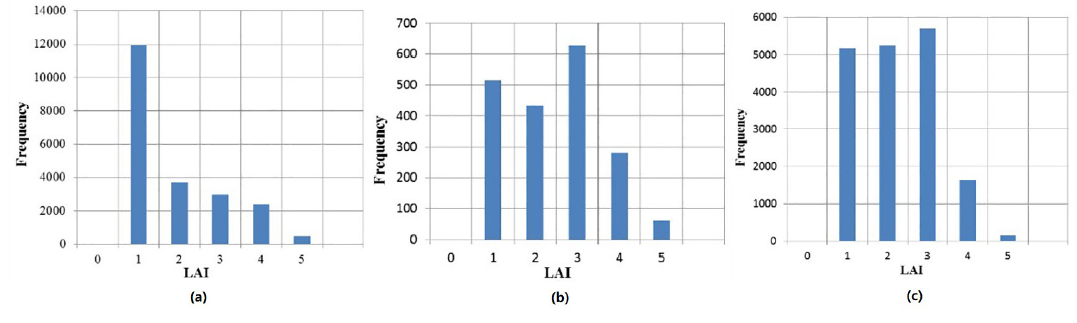
Figure 10. Histogram of LAI from the LAI-SR samples of SMEX02. ( a ) dataset A1 (upscaled Landsat reflectance at the 500-m resolution and MODIS LAI products); ( b ) dataset A2 (MODIS reflectance and LAI products); ( c ) dataset B (unmixed MODIS surface reflectance and LAI products at 30-m